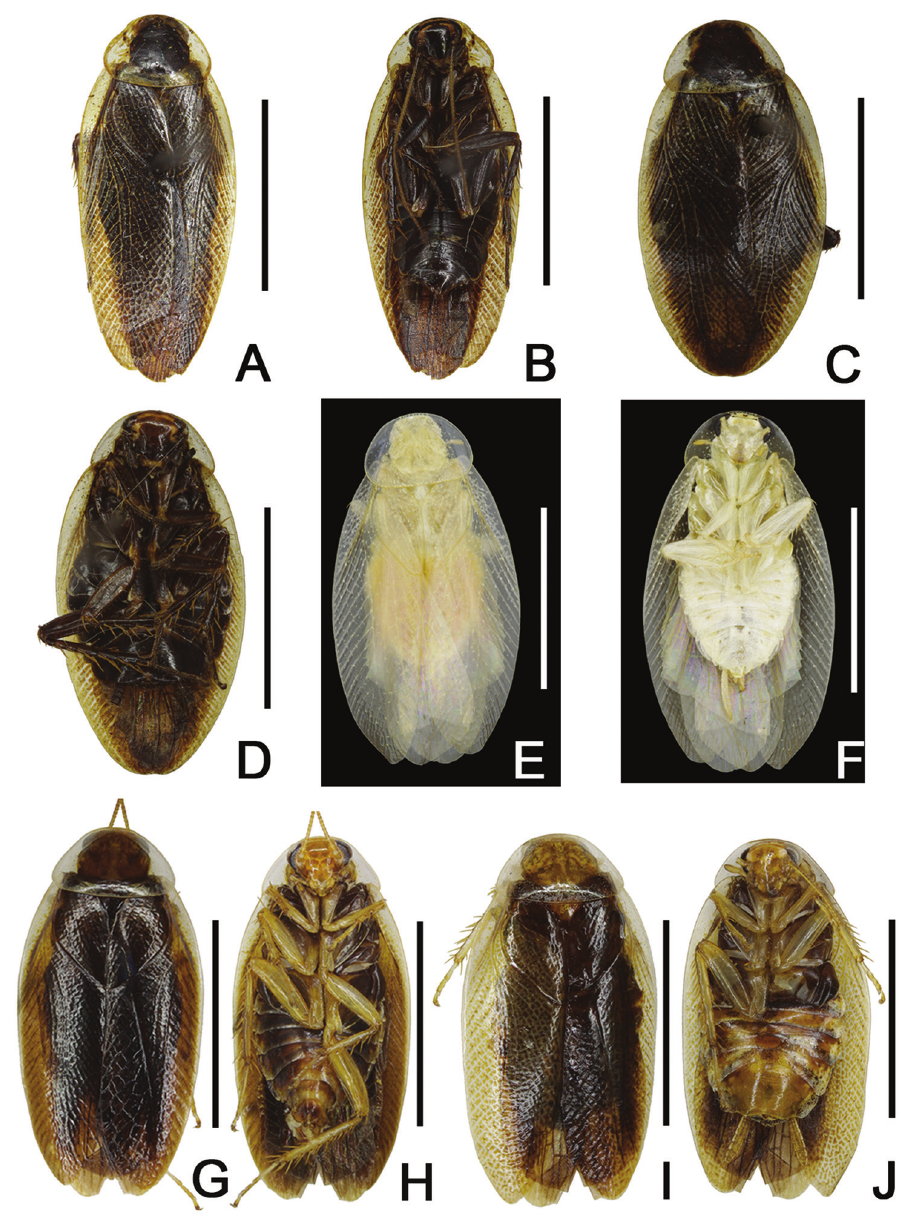
Figure 12. Habitus. A, B S. bivitta (Bey-Bienko, 1969) male from China, Guangxi, Hechi, Mt. Da- qingshan, dorsal and ventral views C, D S. bimaculata sp. n. paratypes, male from China, Chongqing, Wulong, Wanfeng, dorsal and ventral views E, F S. viridis sp. n. holotype, dorsal and ventral views G–J S. hispida sp. n. G–H male paratypes, dorsal and ventral views I, J female paratypes, dorsal and ventral view. Scale bars: 5